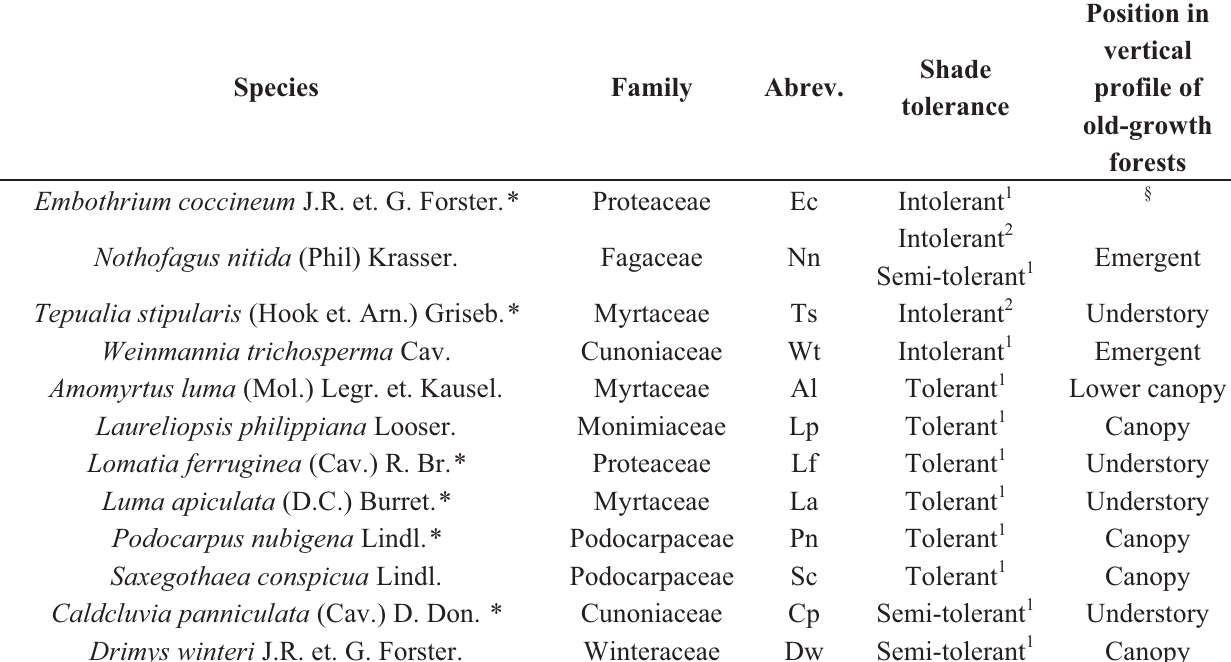
Table 1. Shade tolerance of the main tree and woody species mentioned in this study. Species Family Abrev.